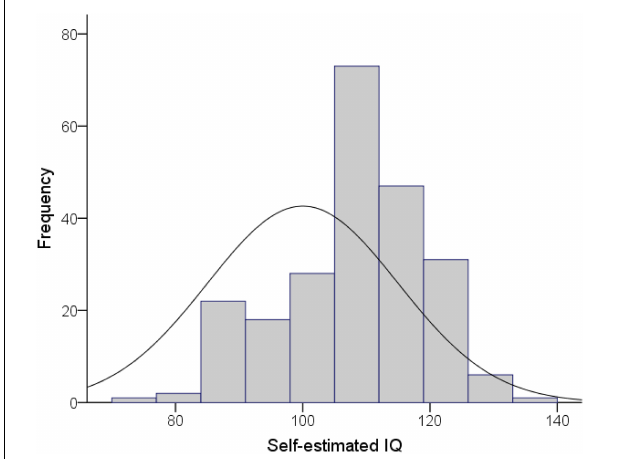
FIGURE 2 | Histogram showing the distribution of self-estimated intelligence in the present sample, alongside the normal distribution of IQ scores in the general population. Our sample was significantly negatively skewed with the bulk of scores shifted to the right of the normal